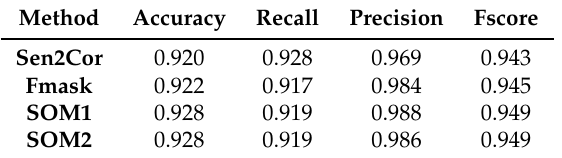
Table 4. Evaluation metrics of Sentinel-2 cloud masks (entire test set).